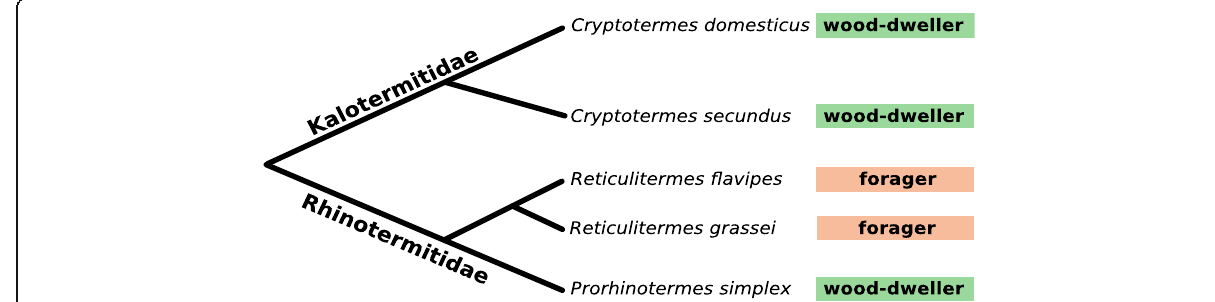
Fig. 1 Schematic phylogeny of the five lower termite species used in this study from [33]. Branch length not drawn to scale. Colored boxes indicate the life